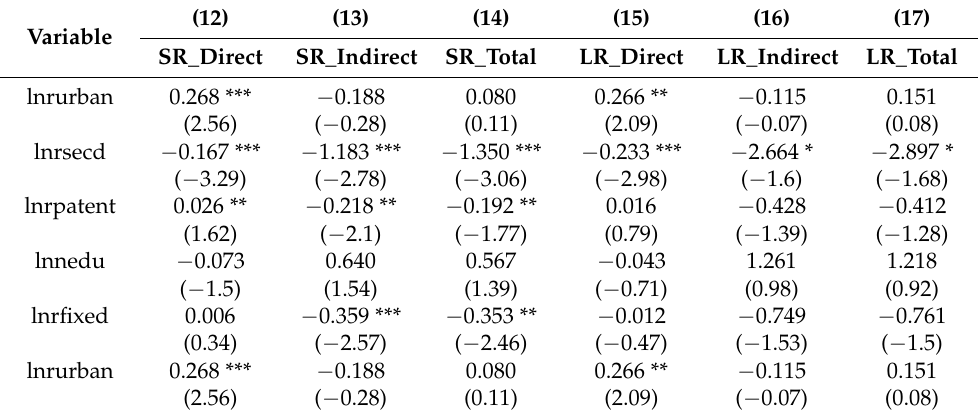
Table 7. The estimation result of the spatial spillover